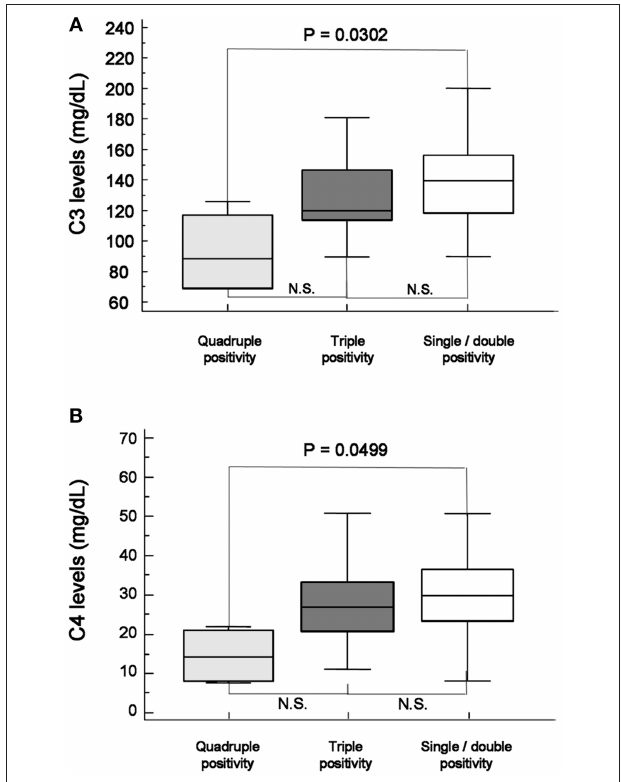
FIGURE 4 | Mean levels of C3 (A) and C4 (B) complement factor in patients with sicca and quadruple aPL positivity (gray) were significantly lower than patients with sicca and single/double aPL positivity(white). When they were compared with patients with triple positivity (dark), they were also lower, but did not become significant.